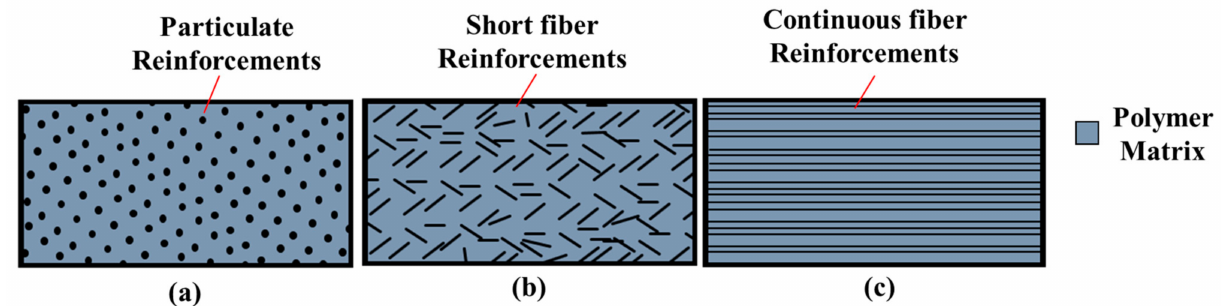
Figure 4. Various reinforcement materials used in composite filaments: ( a ) Particulate reinforcement, ( b ) short fiber reinforcement, and ( c ) continuous fiber reinforcement composites.